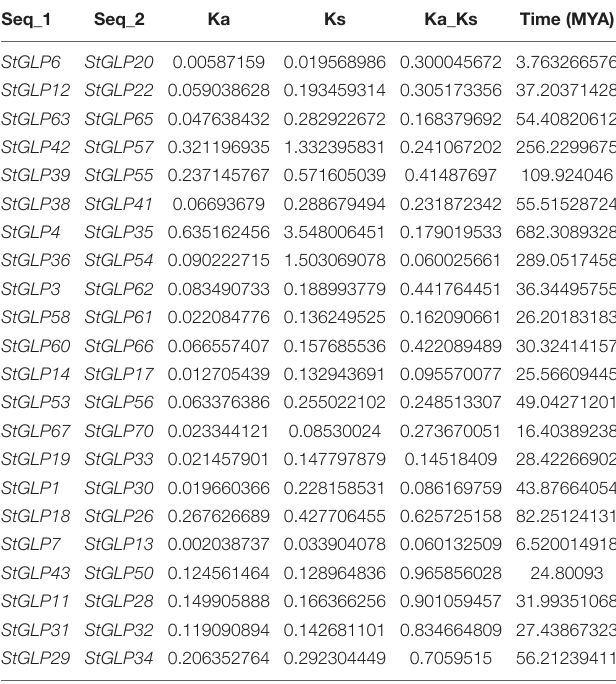
TABLE 2 | Gene duplication and selection pressure of StGLPs